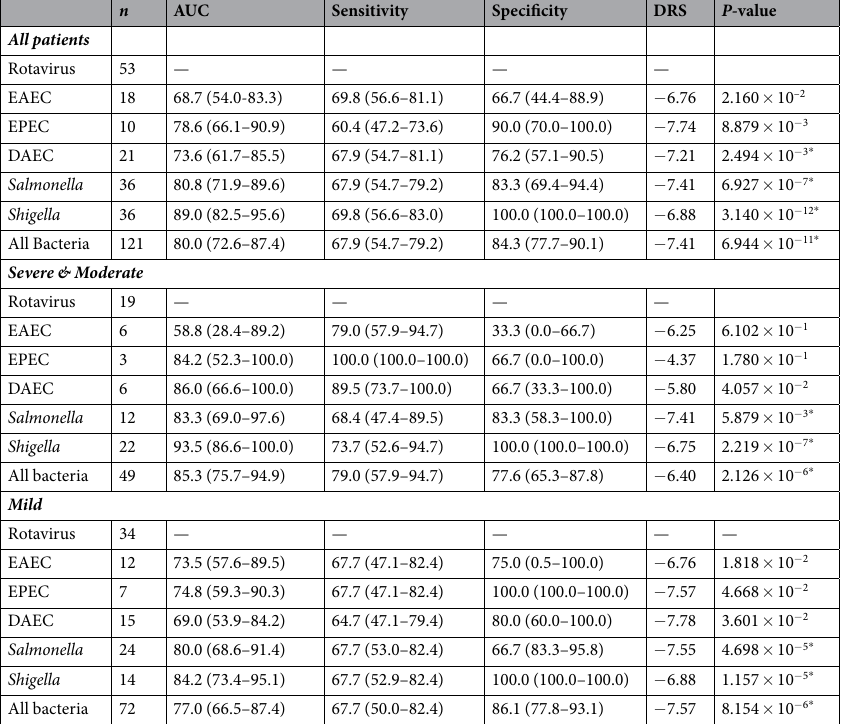
The diagnostic accuracy of the test to discriminate viral from bacterial diarrhea was evaluated using ROC analysis (Fig. 2B), and considering different scenarios: ( i ) all the bacterial infections against rotavirus, and ( ii ) each bacterial pathogen (EAEC, DAEC, EPEC, Salmonella , and Shigella ) against rotavirus. For the first scenario, the ROC curve indicates that the accuracy of the test is ~80%, a value that is comparable to that reported by